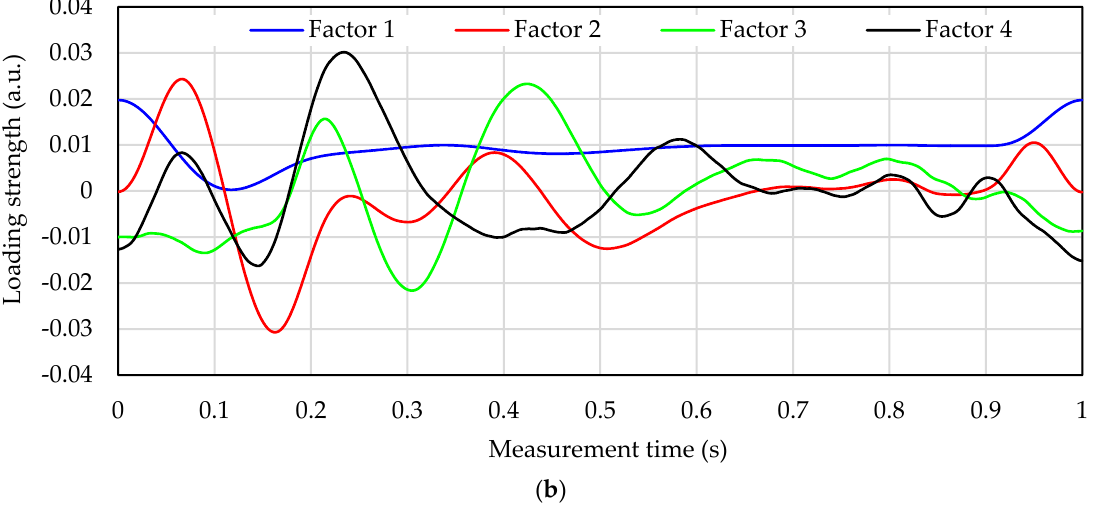
Figure 6. Loading vector of calibration curve in subject D. ( a ) Loading vector of calibration curve in shortest-time-cut process; ( b ) Loading vector of calibration curve in the 1-s-normalization process.